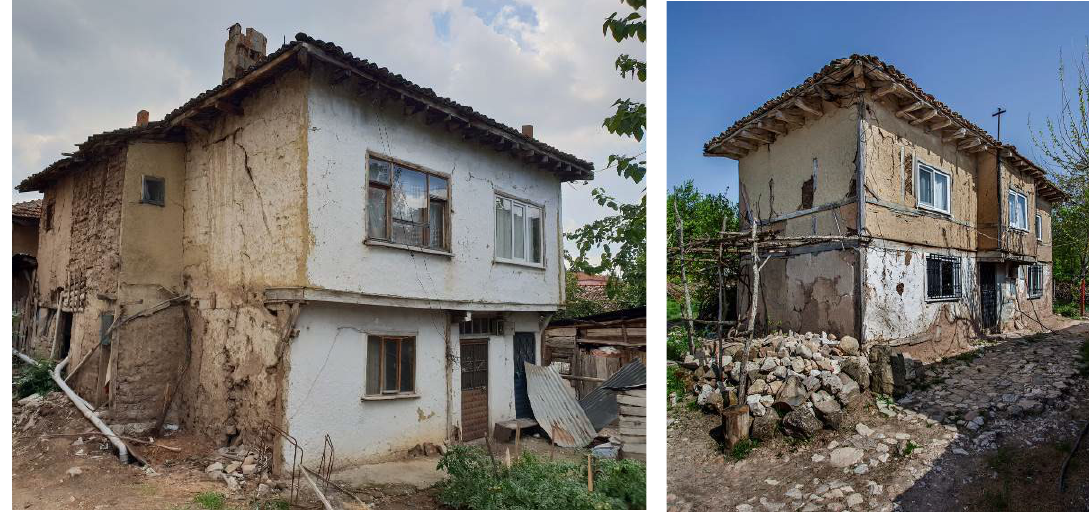
Figure 19 PVC joinery and iron door renovation in houses